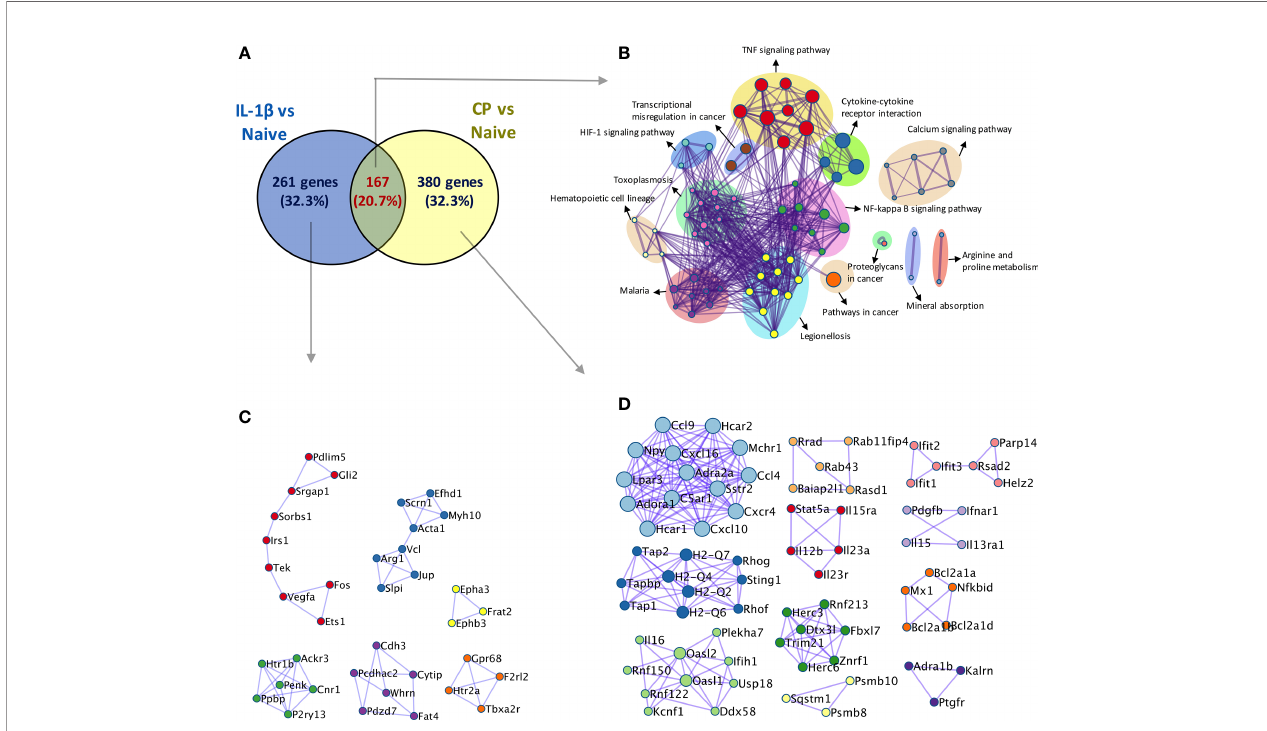
FIGURE 6 | Comparison of transcriptomic activation of desialylated and IL-1 b -stimulated SFs. Bulk RNA-Seq (75bp paired-end, 30M reads, n = 3) was performed on i) naïve and IL-1 b -stimulated, and ii) non-treated and C. perfringens -treated naïve SFs, to identify DEGs (Padj < 0.01 and |foldchange| > 2) in both experimental conditions. (A) Venn diagram shows the number of overlapping and unique DEGs identi fi ed in the IL-1 b vs naïve and CP vs NT comparisons. (B) Overlapping genes identi fi ed in (A) were used to perform pathway enrichment using the bioinformatics tool Metascape. (C) Unique genes in IL-1 b vs naïve and (D) unique genes in CP vs NT identi fi ed in (A) were used to perform protein-protein interaction enrichment in